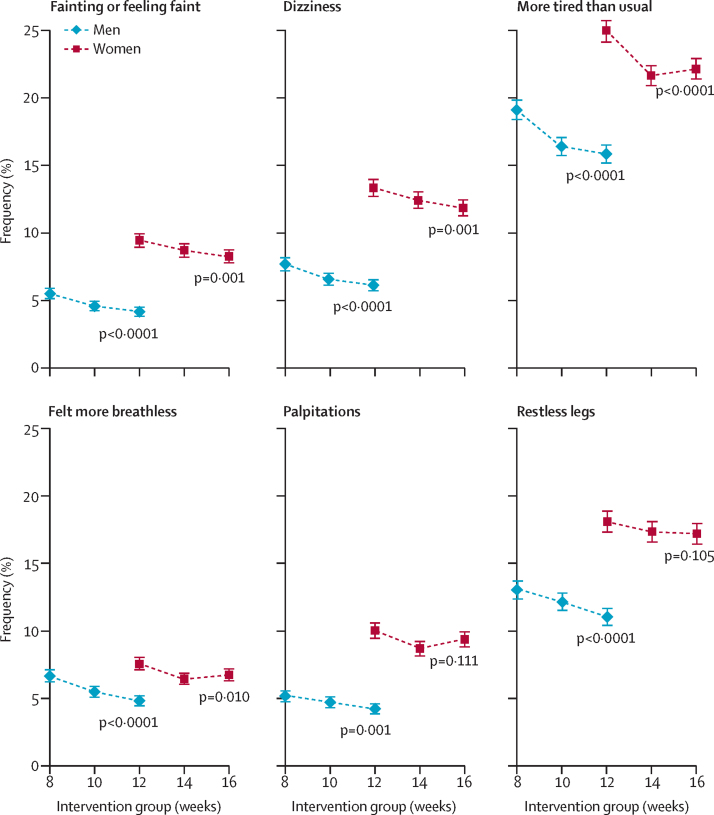
Self-reported symptoms during the 2-year trial period by sex and intervention groupThe p values assess trends across randomised groups, adjusted for baseline characteristics (centre, age, weight, and new donor status).